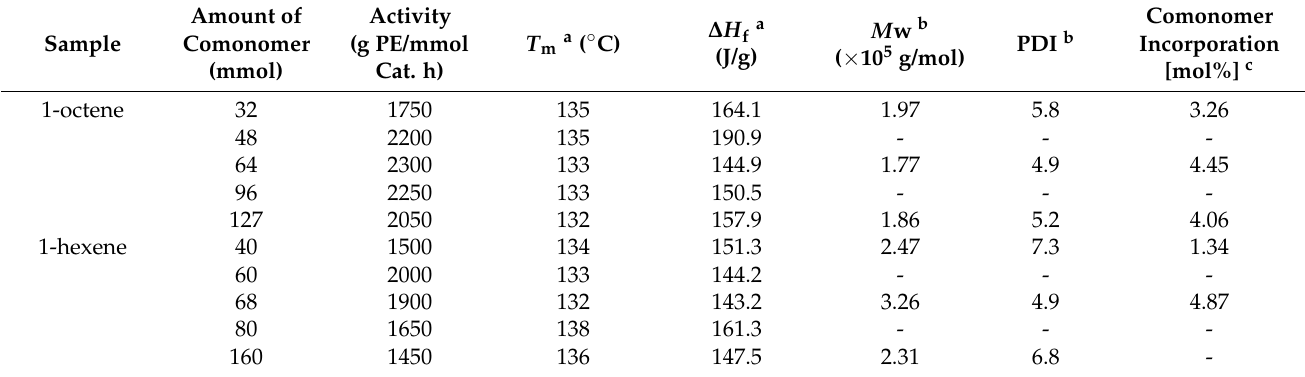
Table 4. Copolymer activities of different comonomers and polymer